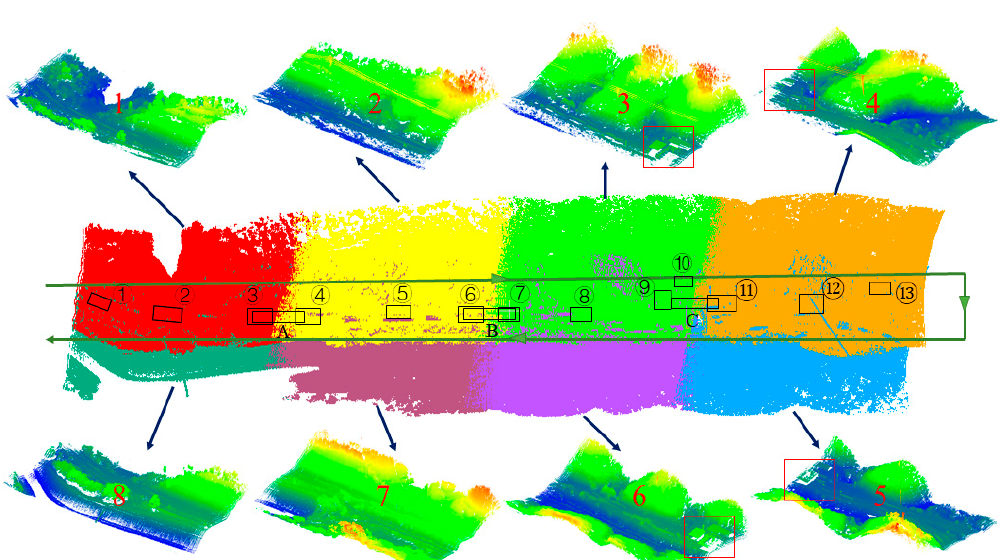
Figure 4. Strip data and serial number after preprocessing. There are continuous hills, undulating terrain, an expressway, an ordinary road, a high-voltage power line, and a toll station (in red rectangles). A more complete experimental region can be seen in Figure 5. The green line is the flight trajectory of the unmanned aerial vehicle (UAV) and the black rectangles mark the position of the planes used to calculate the root-mean-square error (RMSE) in subsequent experiments.